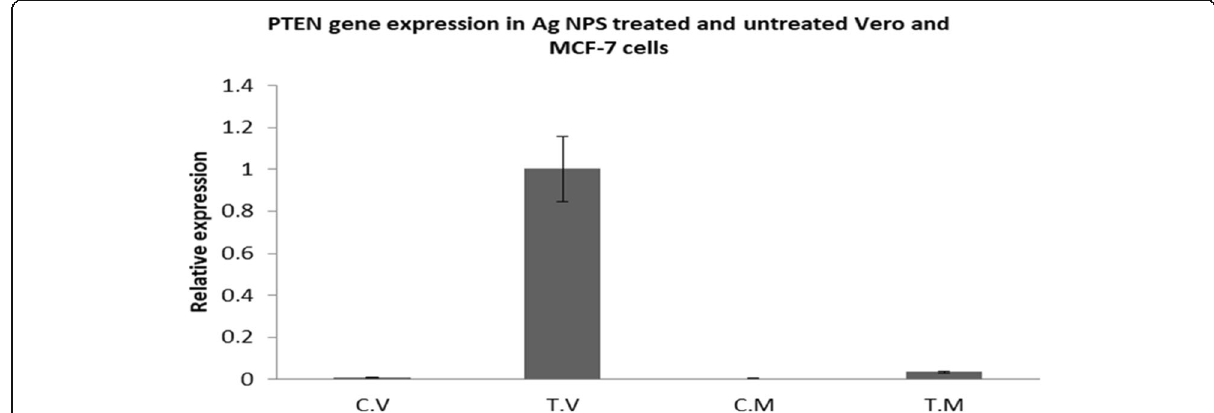
Fig. 9 PTEN relative expression in MCF-7 and Vero cell treated or untreated with Ag NPs. Total RNA was extracted, reverse transcribed, and the synthesized DNA was used as a template for qPCR relative expression assay using SYBR green master mix. Data were analyzed by ΔΔ CTs and normalized to ( β -actin) house-keeping gene ( t test P > 0.05,